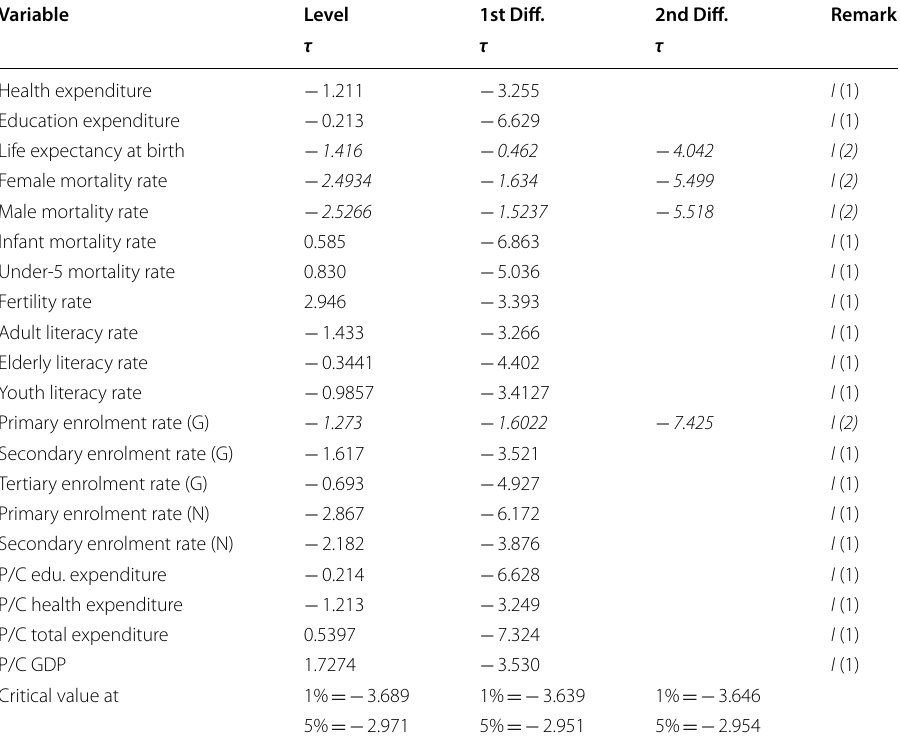
Table 1 Test of stationarity of health and education expenditures and health output Variable Level 1st Diff. 2nd